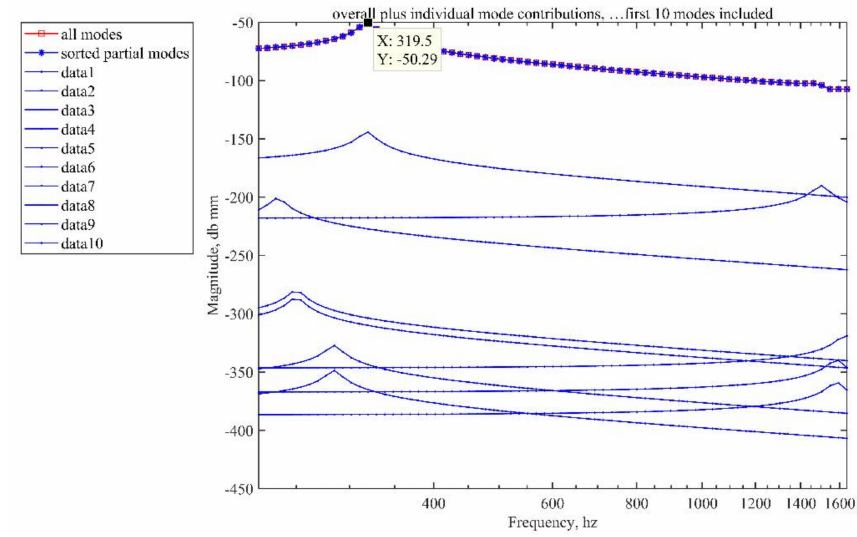
Figure 11. Overall plus individual mode contributions for the ten sorted mode model.